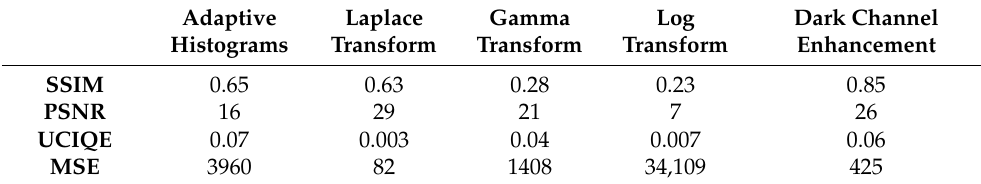
Table 3. Comparison of enhancement